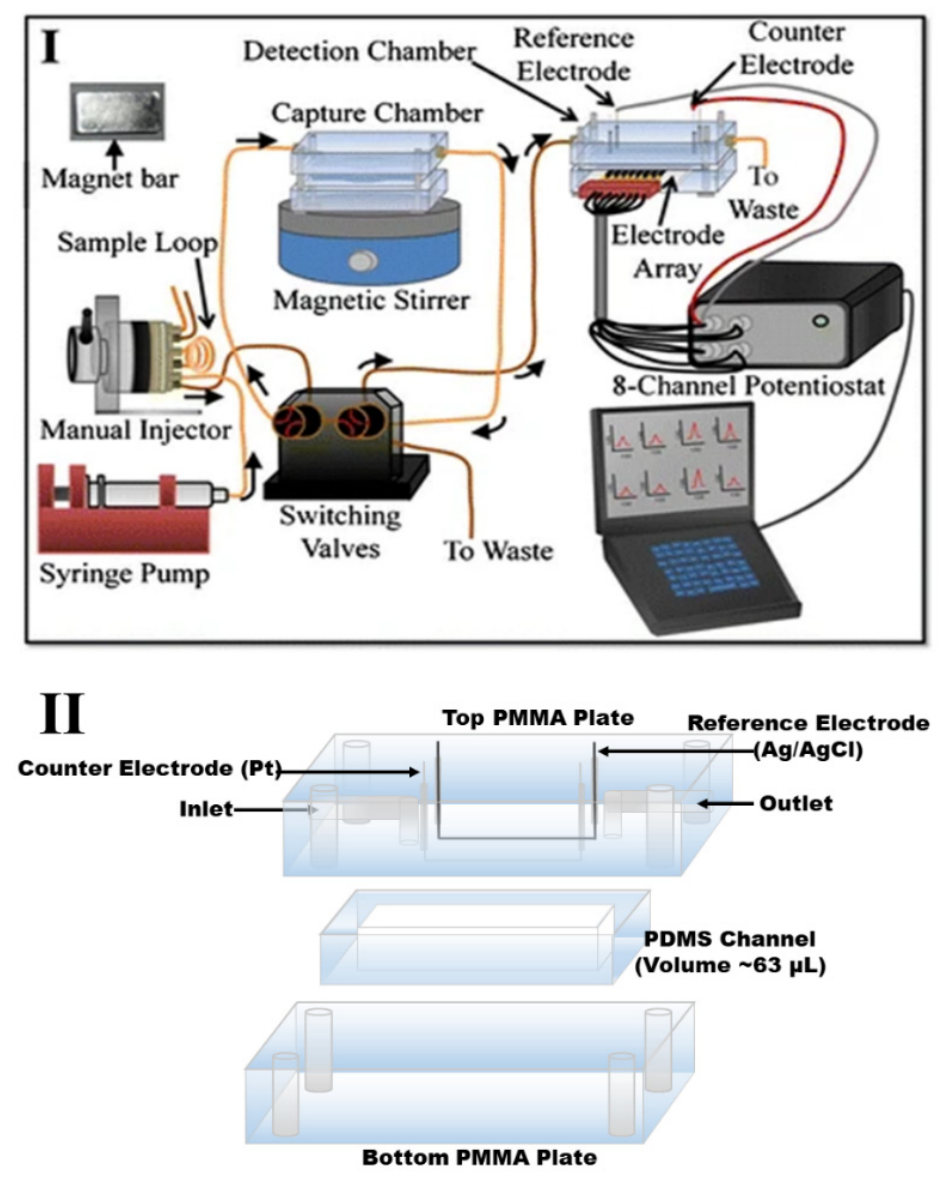
Figure 6. The microfluidic set-up used by our group in electroimmunosensors. ( I ) Schematic diagram of the pump (used for the flow of wash bu ff ers and hydroquinone mediator into the detection chamber), HPLC injector (used for the injection of the sample into the detection chamber), switching valve (for alternation of the direction of fluids into the detection chamber, capture chamber or the waste), microfluidic chamber (houses the electrodes and the detection chamber), and the eight-channel multipotentionstat for amperometric detection of the analytes. ( II ) The microfluidic chamber with a poly (dimethoxy) silane channel (1.5 mm × 2.8 cm) sandwiched between two hard poly (methylmetacrylate) (PMMA) plates. The upper PMMA plate houses the platinum counter electrode and the Ag / AgCl reference electrode. Reprinted with permission from [101], copyright 2015 Springer Nature.